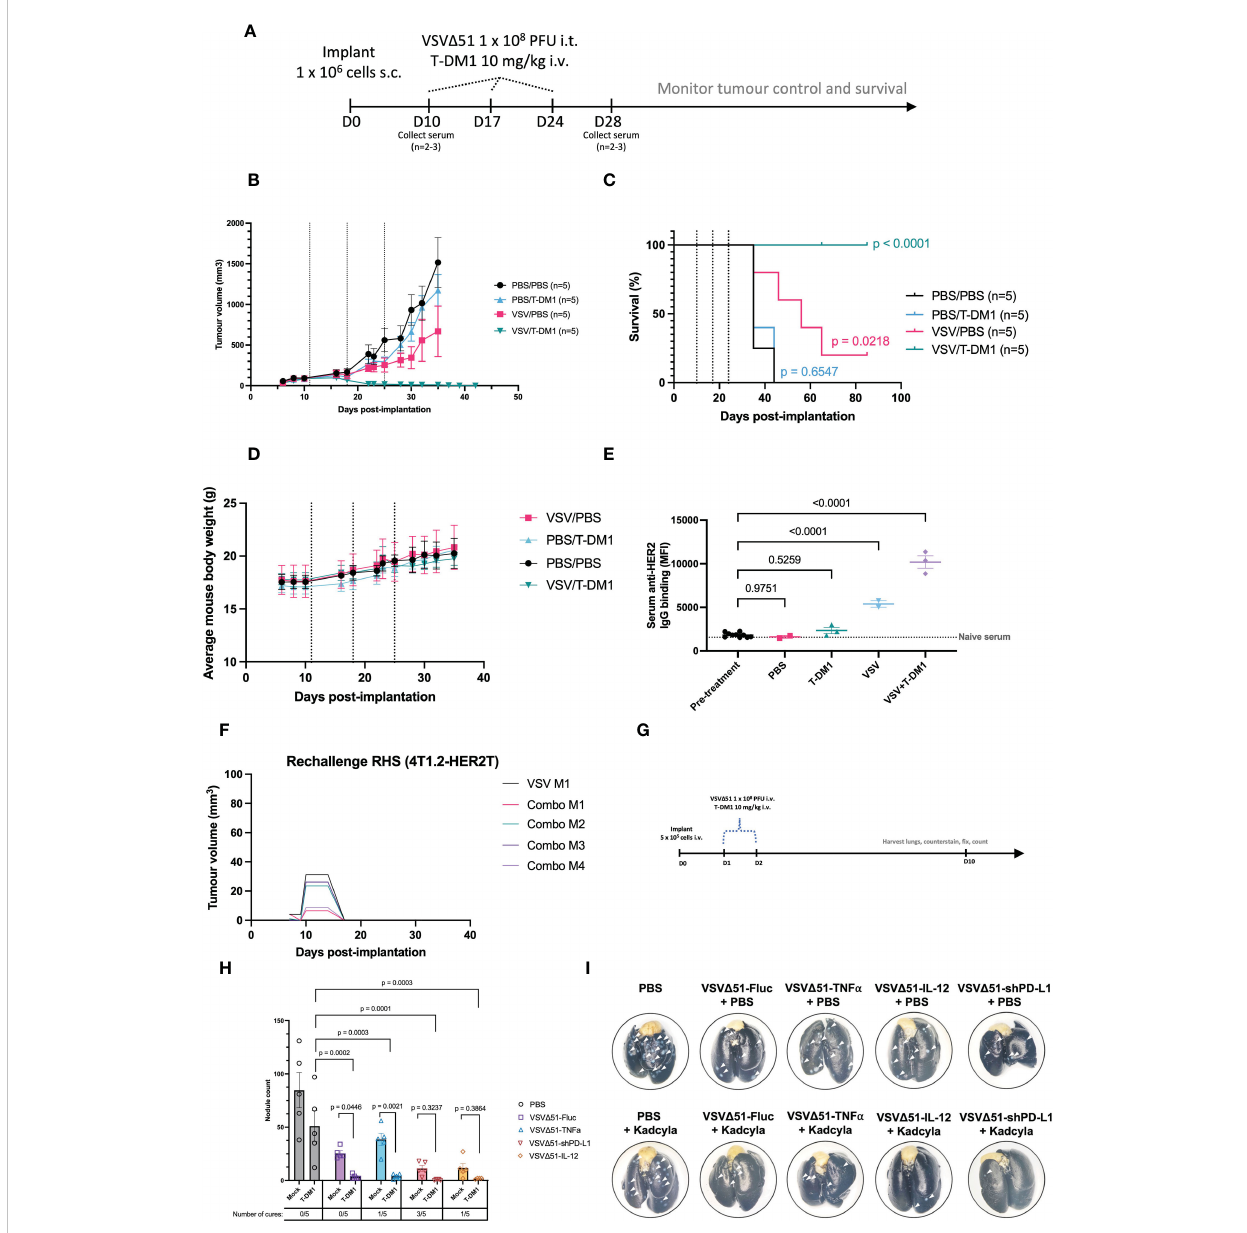
FIGURE 6 Treatment of 4T1.2-HER2T tumours with VSV D 51 and T-DM1 combination leads to durable cures and reduced lung metastasis in vivo. (A) Tumour implantation and treatment regimen timeline (B, C) Following implantation and treatment as in (A) , mouse (B) tumour control and (C) survival were monitored. Dotted lines indicate treatments. Survival data p-values relative to PBS control. (D) Mouse weights measured over time as a wellness indicator. (E) Serum was collected from mice 4 weeks post-treatment. HER2-reactive IgG was measured by incubation with JIMT1 cells. The dotted line represents naïve mouse serum control. (mean ± SEM, PBS n=2, T-DM1 n=3, VSV D 51 n=2, VSV D 51+T-DM1 n=3; one-way ANOVA with Dunnett ’ s correction for multiple comparisons, relative to pre-treatment) (F) Cured mice from (A – C) were rechallenged with 4T1.2-HER2T cells (1 x 10 6